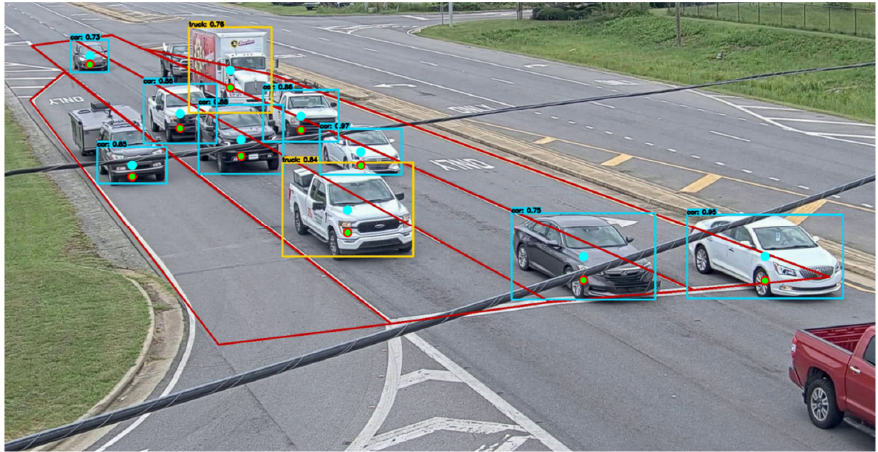
Figure 8. Vehicle detection and localization in real-time video captured by a traffic camera.